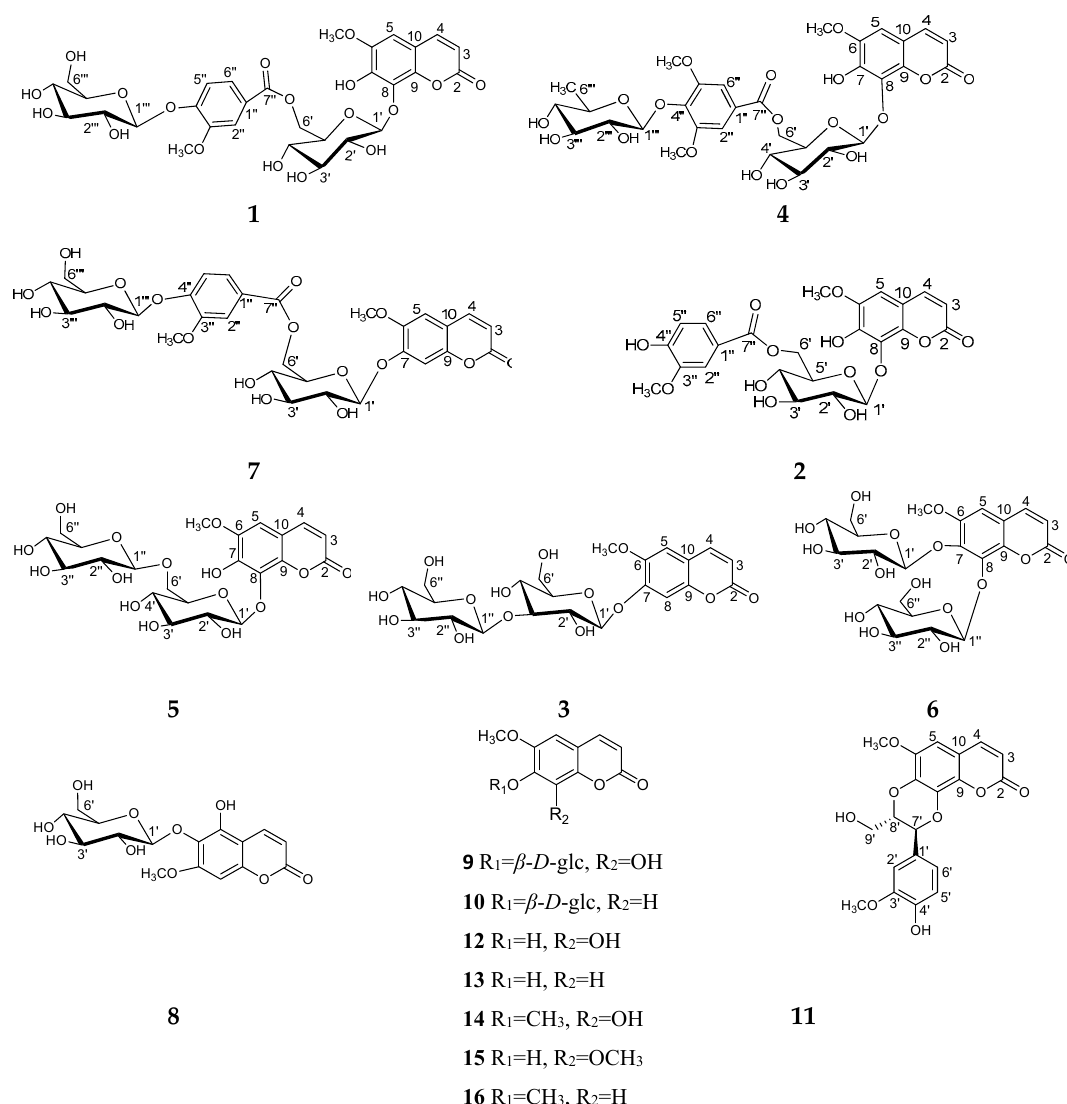
Figure 1. The chemical structures of compounds 1 – 16 from Gendarussa vulgaris .